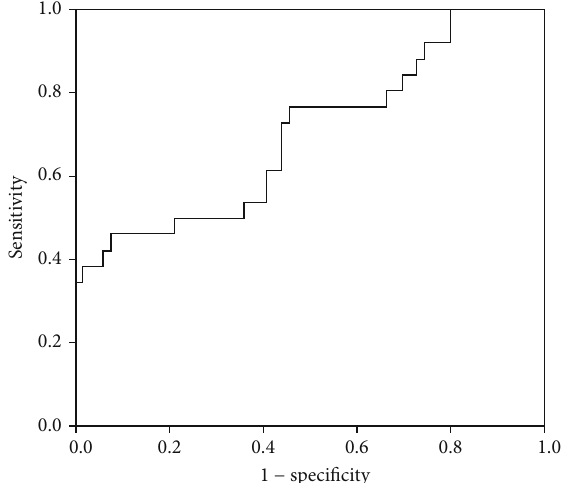
Figure 3: The ROC curve of the DCP/SCP fl ow ratio for predicting the treatment response. The area under the ROC curve was